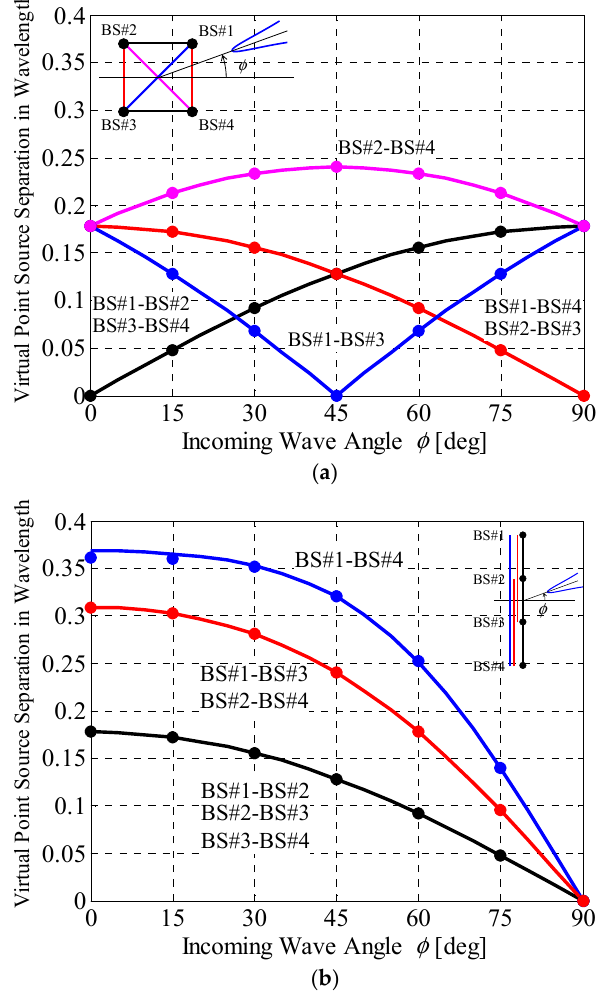
Figure 11. Virtual point source separation vs. incoming wave angle: ( a ) circular array; ( b ) linear array.